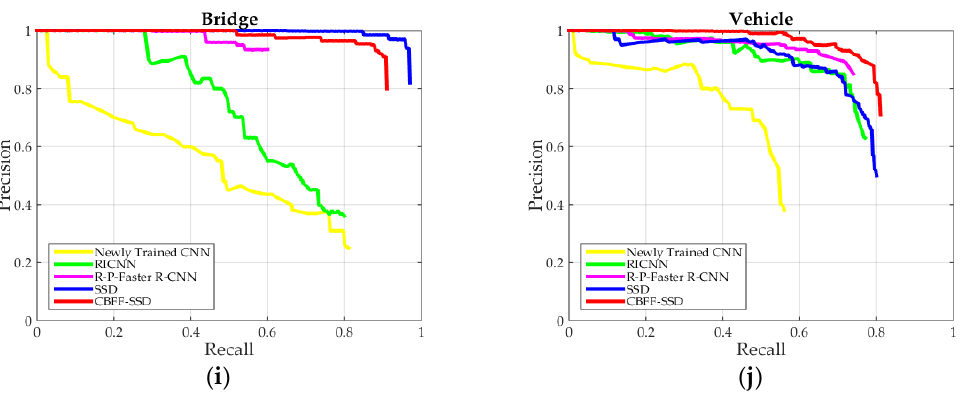
Figure 10. The precision–recall curves (PRCs) of the proposed method and other state-of-the-art methods for 10 classes object in NWPU VHR-10 dataset. ( a ) Airplane; ( b ) ship; ( c ) storage tank; ( d ) baseball diamond; ( e ) tennis court; ( f ) basketball court; ( g ) ground track field; ( h ) harbor; ( i ) bridge; and ( j ) vehicle.